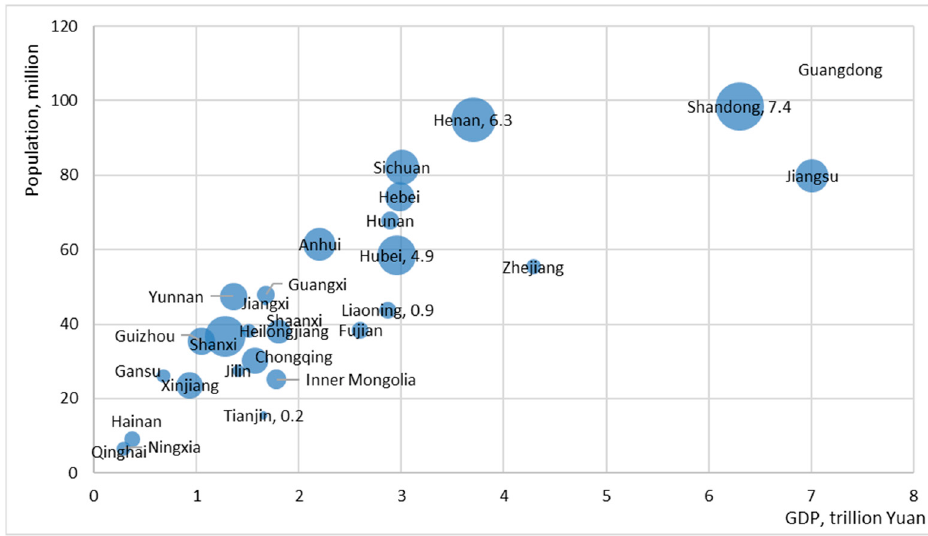
Figure 11. Synthetic ammonia production shares of provinces in China, million tons.